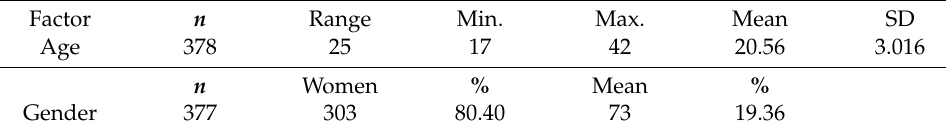
Table 1. Sociodemographic variables of nursing students.